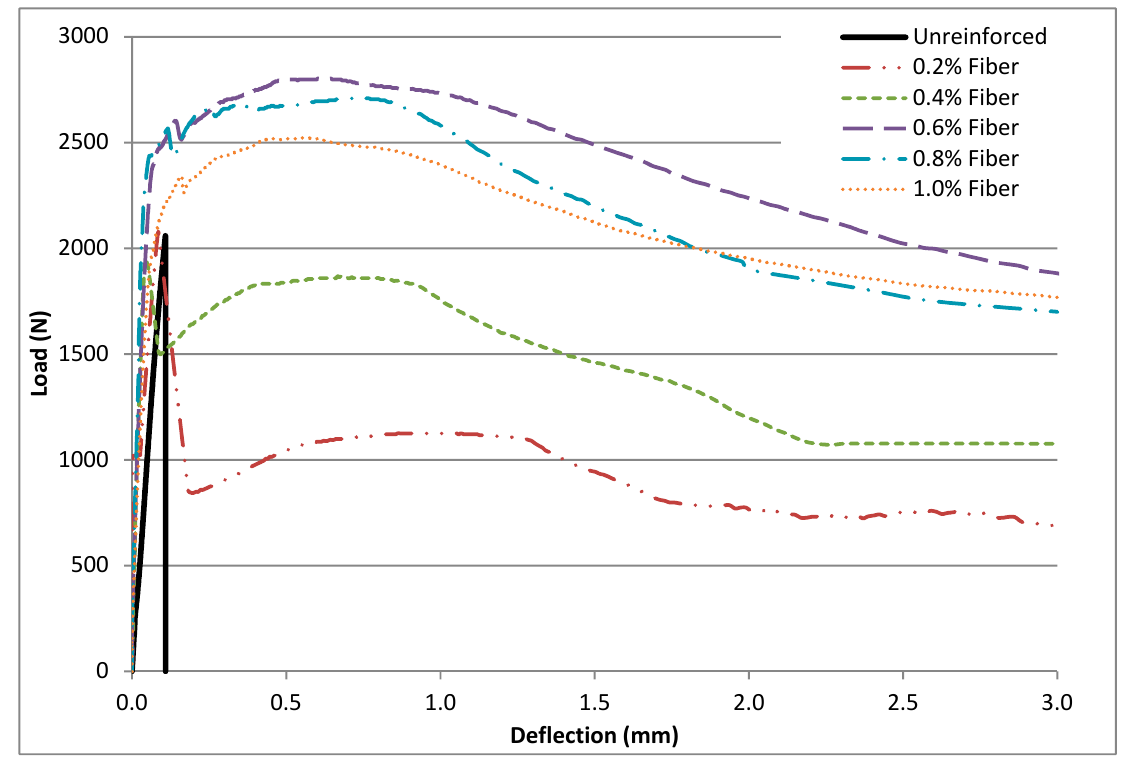
Figure 5. Typical load-deflection curves of specimens.